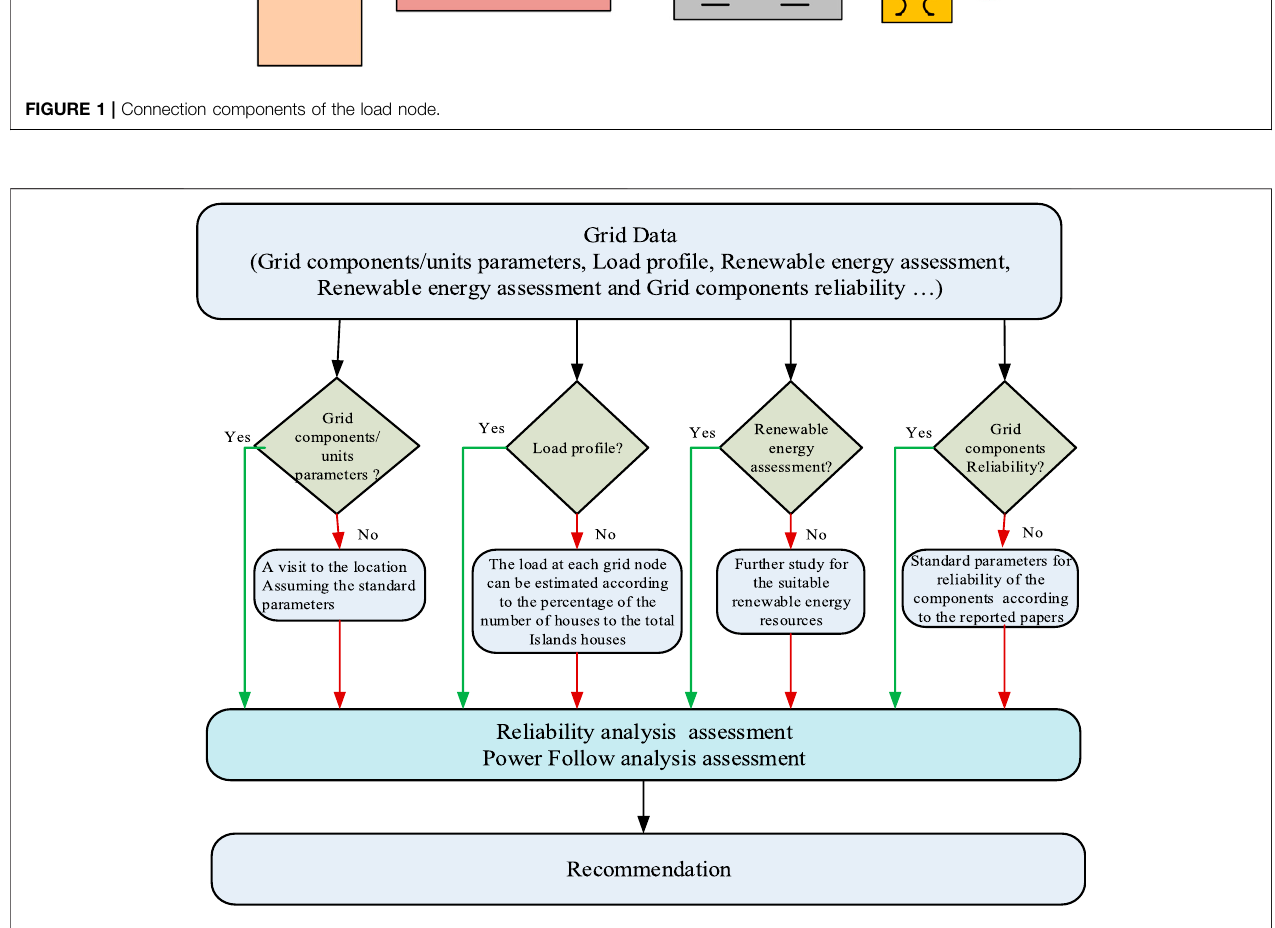
FIGURE 2 | Flow chart for the proposed